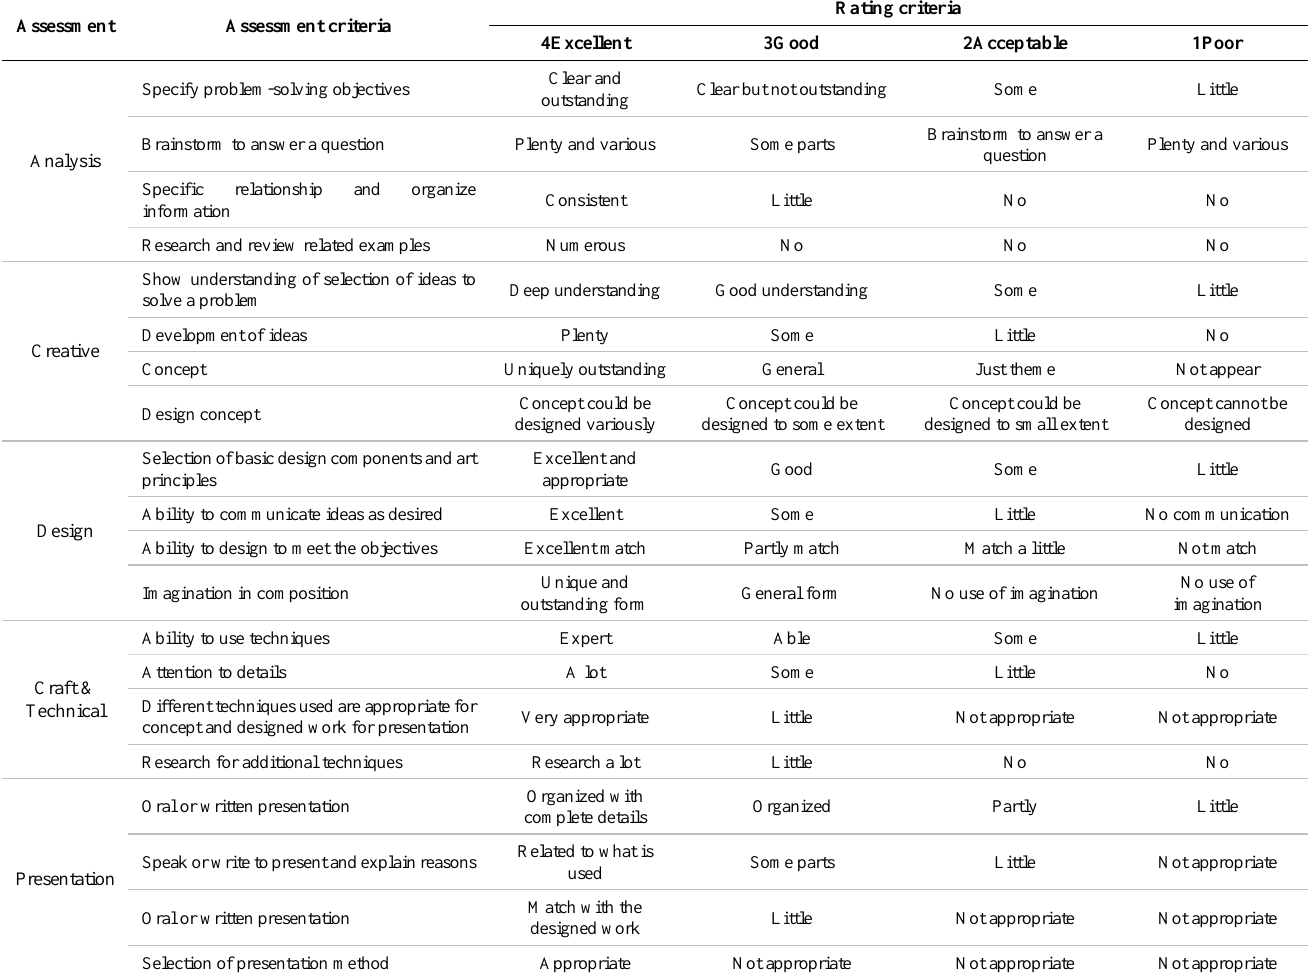
Table 2. Creative works assessment